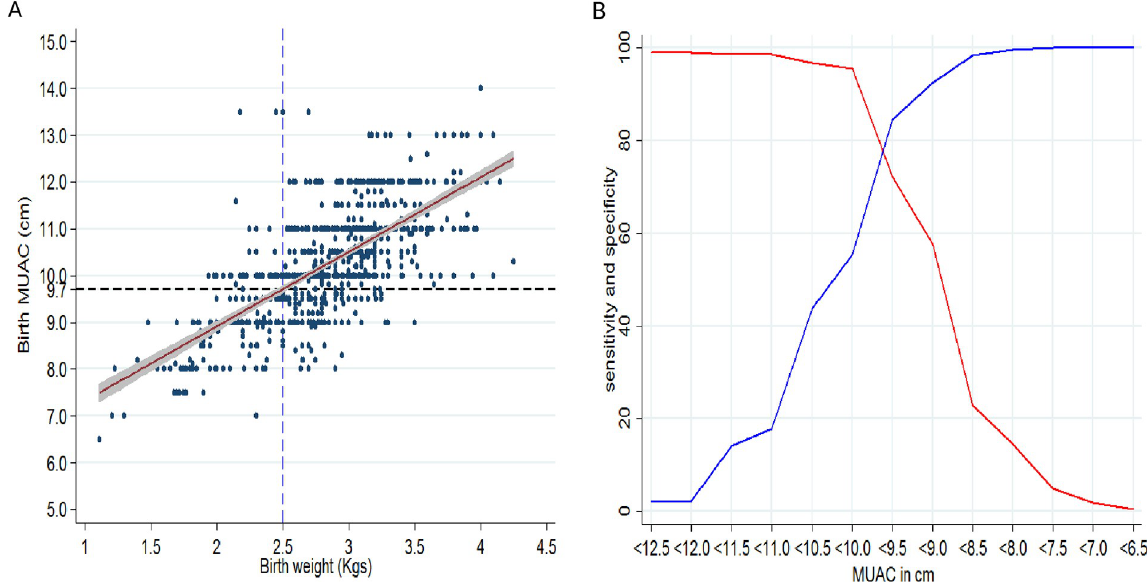
Fig 2. A) A scatter plot of birth MUAC (cm) and birth weight (kg); B) A plot of diagnostic accuracy of different birth MUAC cut offs for LBW (weight <